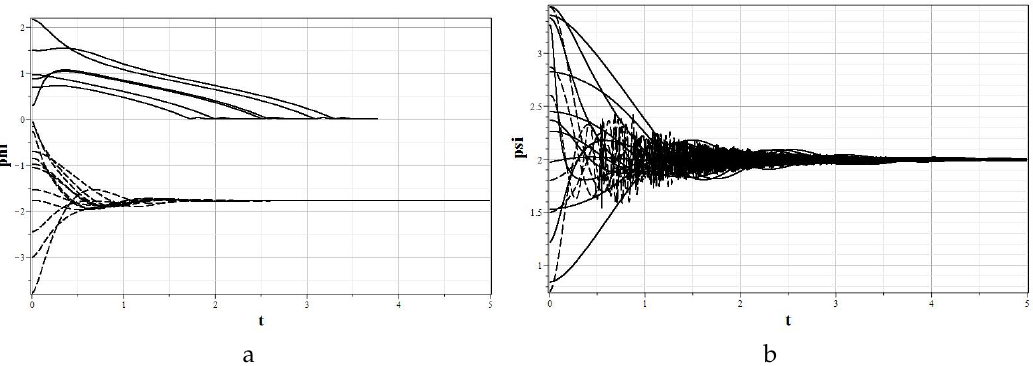
a b Figure 5. Dependence of the fields φ ( a ) and ψ ( b ) on t for the potential (47).